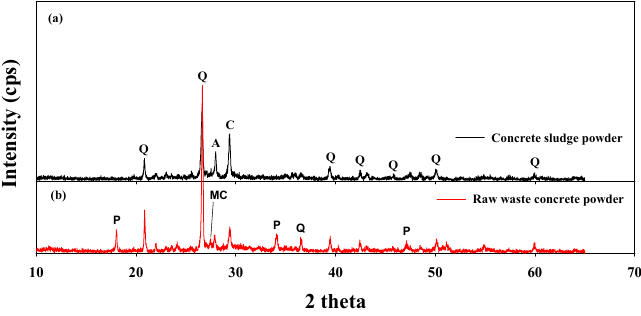
Figure 4. The X-ray diffractogram for concrete sludge powder ( a ) and raw waste concrete powder ( b ); peaks are identified for quartz (Q: SiO 2 ), calcite (C: CaCO 3 ), albite (A: NaAlSi 3 O 8 ), microcline (MC: KAlSi 3 O 8 ) and portlandite (P: Ca(OH) 2 ). Table 2. Chemical composition of dried-solid particles in concrete sludge (XRF analysis).